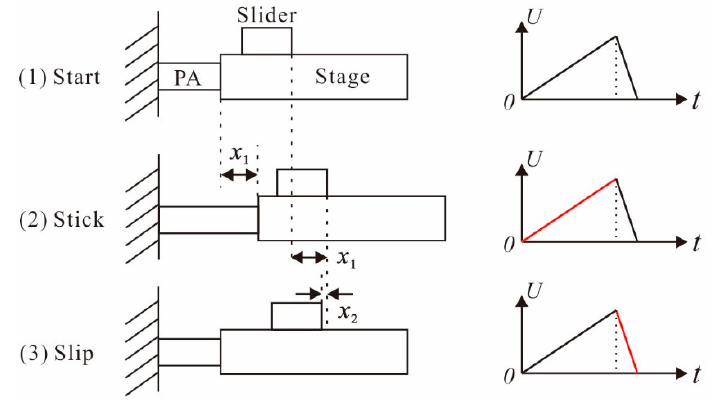
Figure 2. Working principle of 1-DOF PIDM.